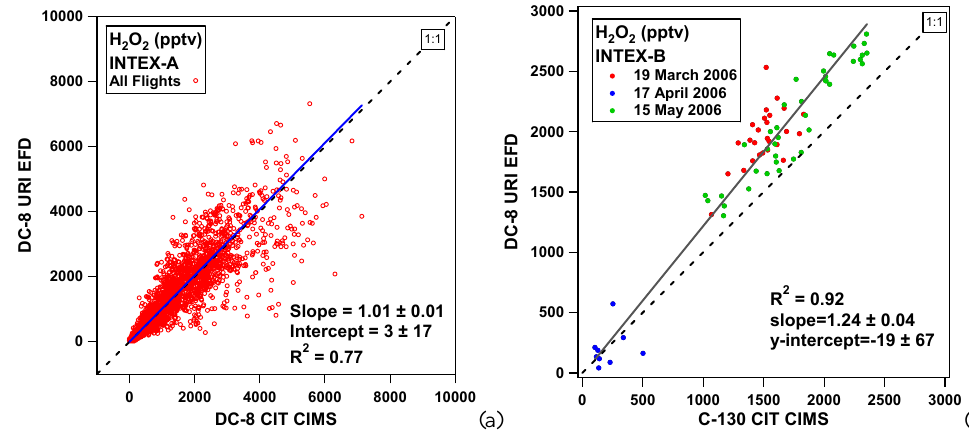
Fig. 4. (a) Scatter plot and orthogonal distance regression for the DC-8 CIMS and EFD H 2 O 2 intercomparison of all INTEX-A flights. (b) Scatter plot and orthogonal distance regression for the DC-8 and C-130 H 2 O 2 INTEX-B intercomparisons on 19 March (red), 17 April (blue), and 15 May (green) 2006. Table 5d. C-130 intra-platform comparison. Nonmethane hydrocarbons, halocarbons, and organic sulfur compounds. NOTE: Technique is listed as X vs.